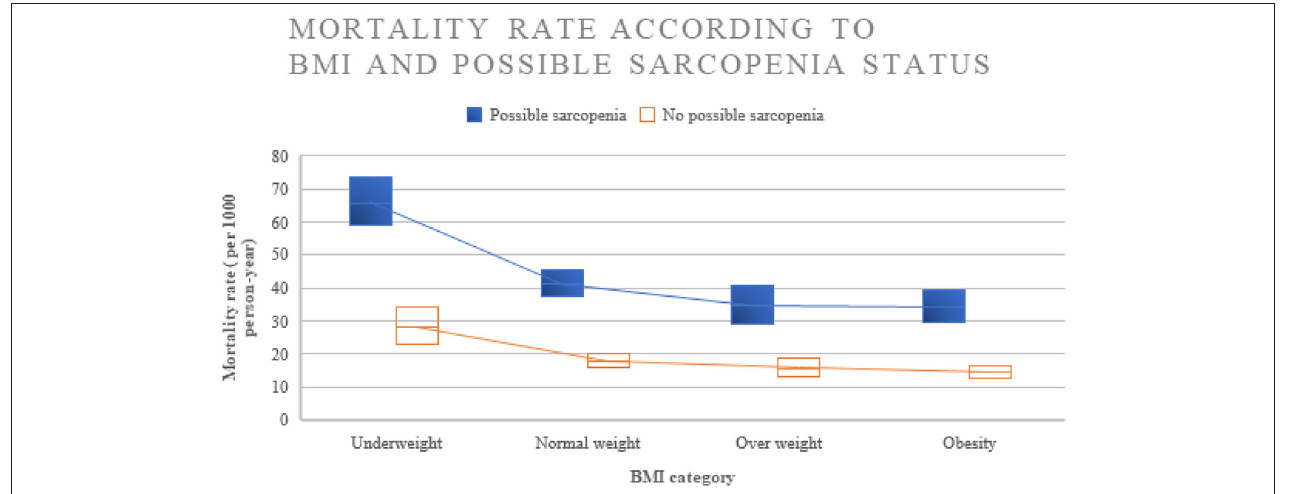
FIGURE 2 | Mortality rate among older people with difference BMI and possible sarcopenia categories.